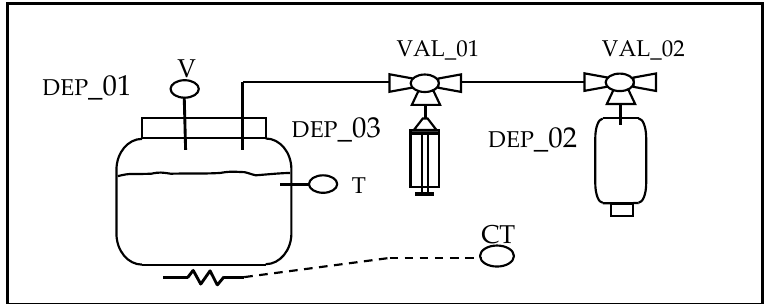
Figure 1. Implementation of the anaerobic digestion system [11].